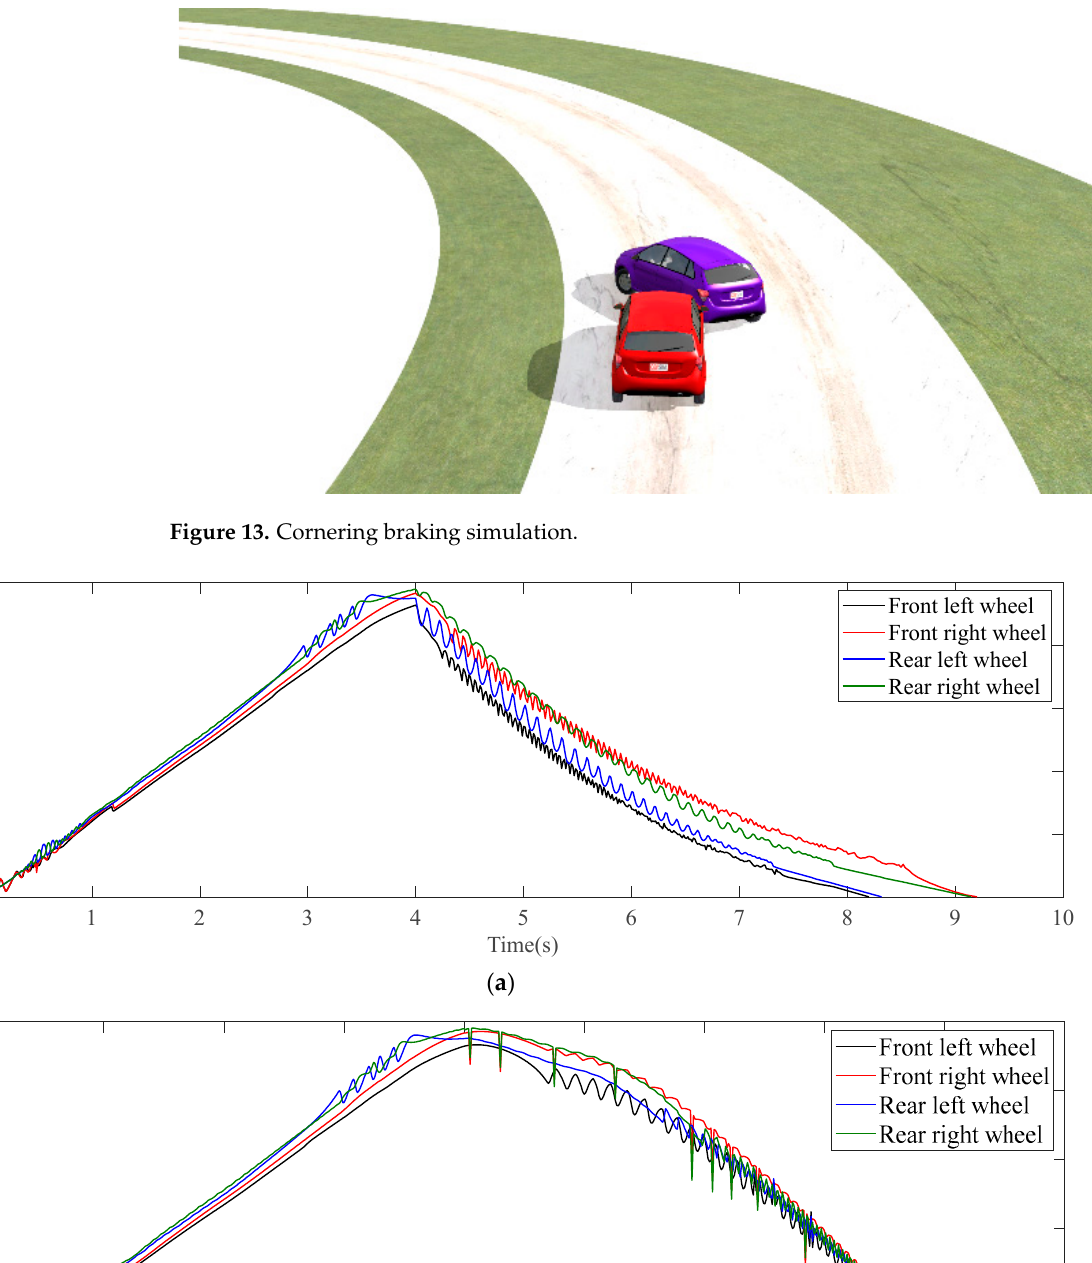
Figure 13. Cornering braking simulation.